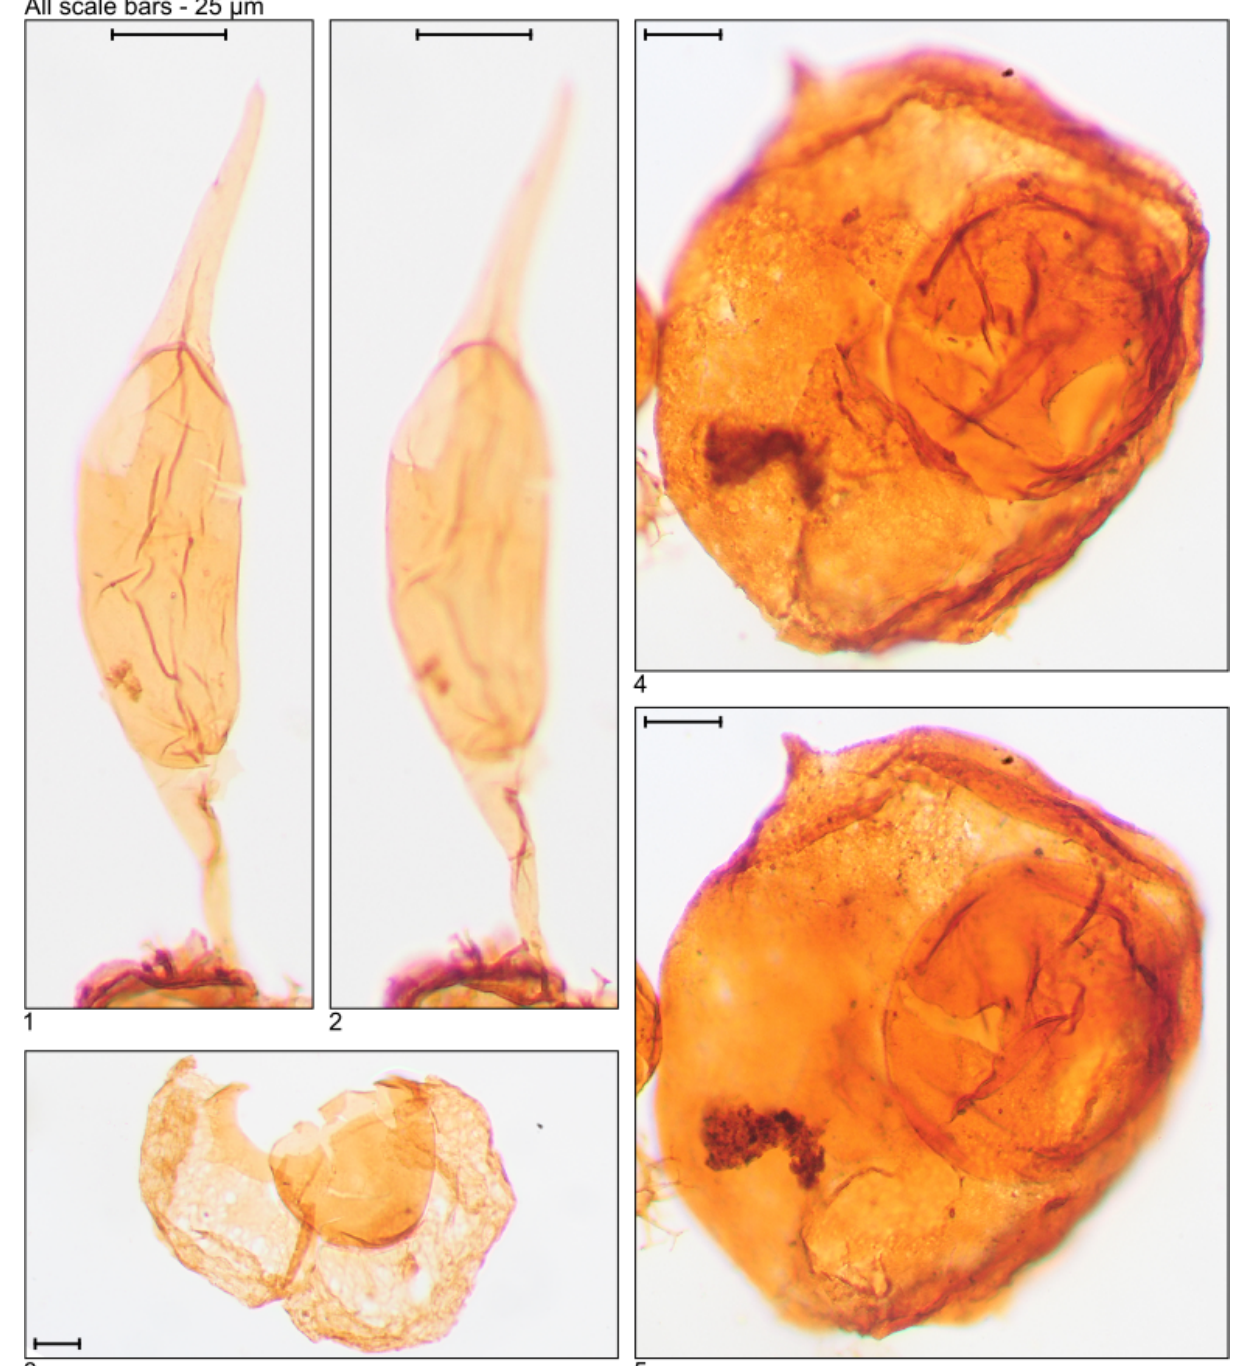
Plate 6. Illustration of taxa and sample or slide number. (1, 2) Svalbardella partimtabulata (MG419; 127.7m; D7-3). (3) Thalassiphora fenestrata (MG175; 53.3m; E21-2). (4, 5) Thalassiphora pelagica (MG499; 152.1m;